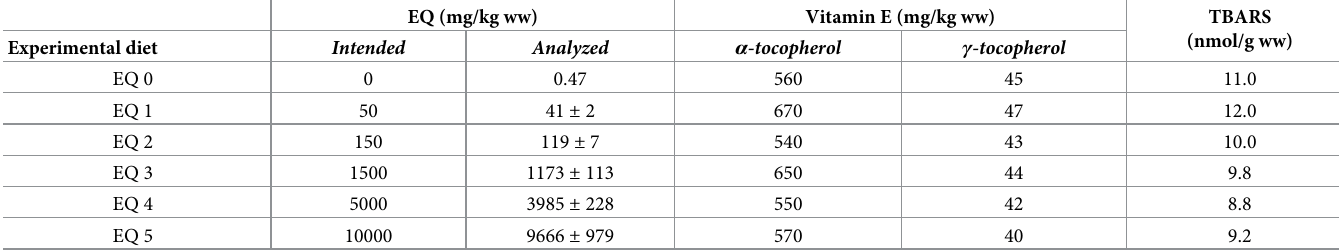
Table 2. Concentrations of ethoxyquin (EQ), vitamin E and TBARS in the experimental diets fed to Atlantic salmon ( Salmo salar L.) for 90 days.